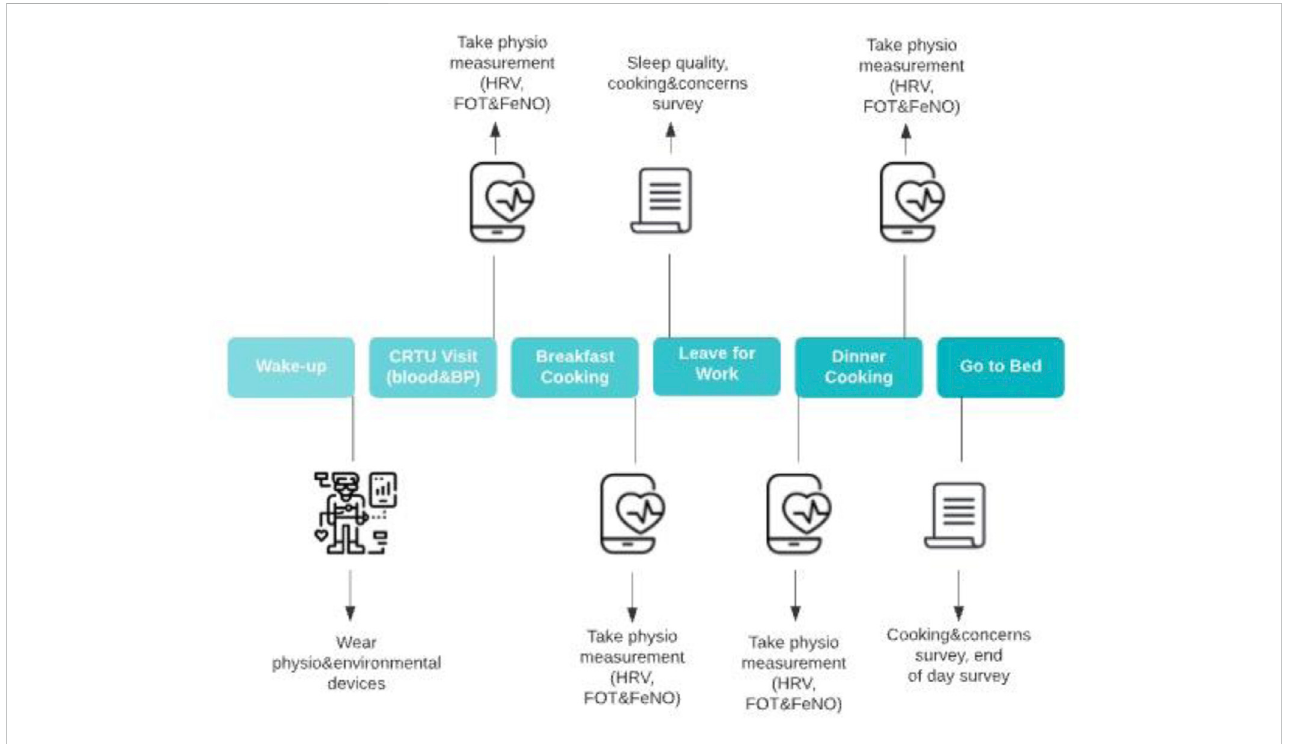
FIGURE 2 Daily schedule of study participant